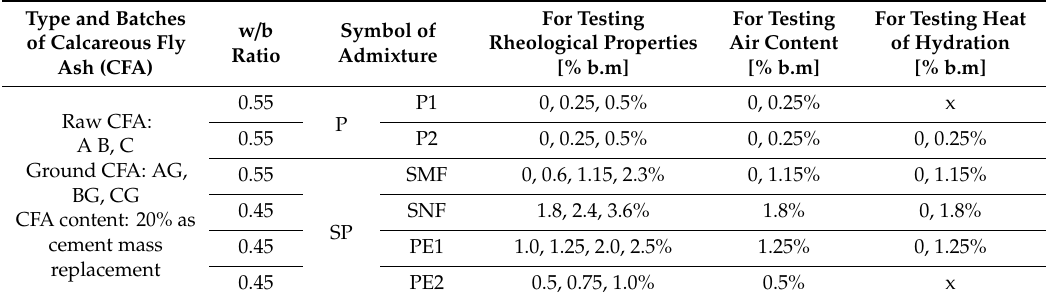
Research plan—type of calcareous fly ash (CFA), w / b ratio, admixture dosage and tested properties.